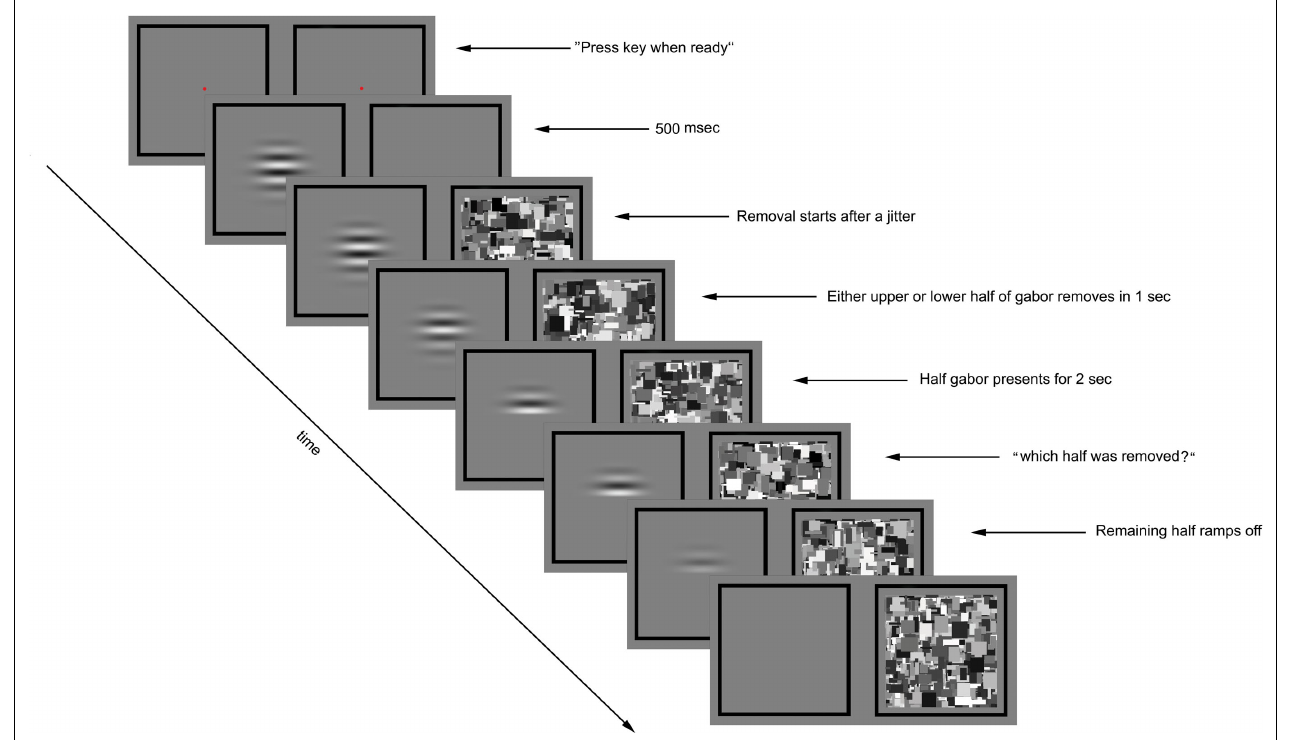
upper or lower half of the gabor was gradually ramped to zero over a 1000-ms period.The other half remained unchanged for 2s before the prompt screen asked about the half removal side, at which time the remaining half of the gabor was removed over a 300ms period.The CFS was displayed to the other until the observer made his/her